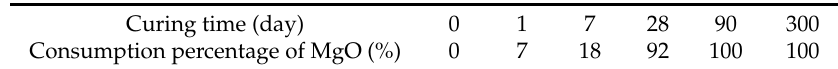
Table 2. Consumption percentage of MgO at curing time.